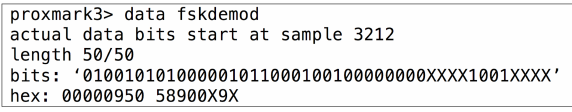
Figure 8. LF tag signal demodulated with